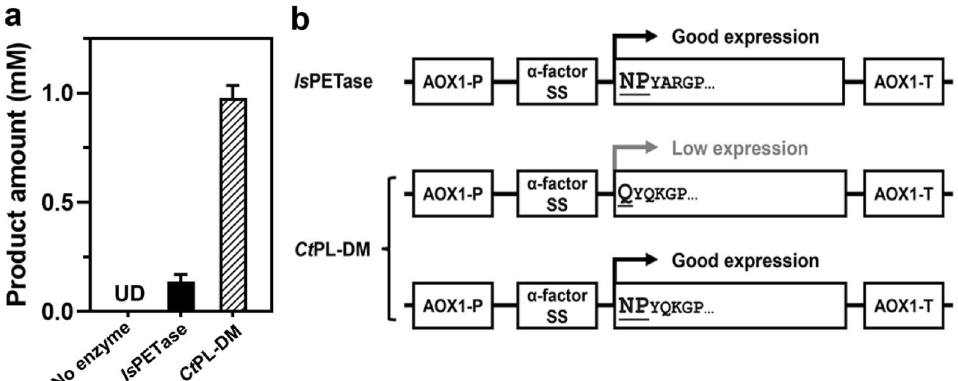
Fig. 1 Comparison of Is PETase and Ct PL‑DM. a Total released PET hydrolytic products of recombinant protein of Is PETase and Ct PL‑DM expressed in E. coli by using GfPET as a substrate. The reaction temperatures of Is PETase and Ct PL‑DM are 30 °C and 60 °C, respectively. Blank control that contained no enzyme in the reaction was also analyzed. A triplicate assay was conducted and the average values presented. b Schematic representation of P. pastoris expression units. The structures of expression unit of pPICZαA vectors carrying Is PETase and Ct PL‑DM are depicted. The amino acids in the N‑terminal part of each expressing sequences were displayed. AOX1‑P, P. pastoris alcohol oxidase 1 promoter; α‑factor SS, α‑factor secretion signal; AOX1‑T, P. pastoris alcohol oxidase 1